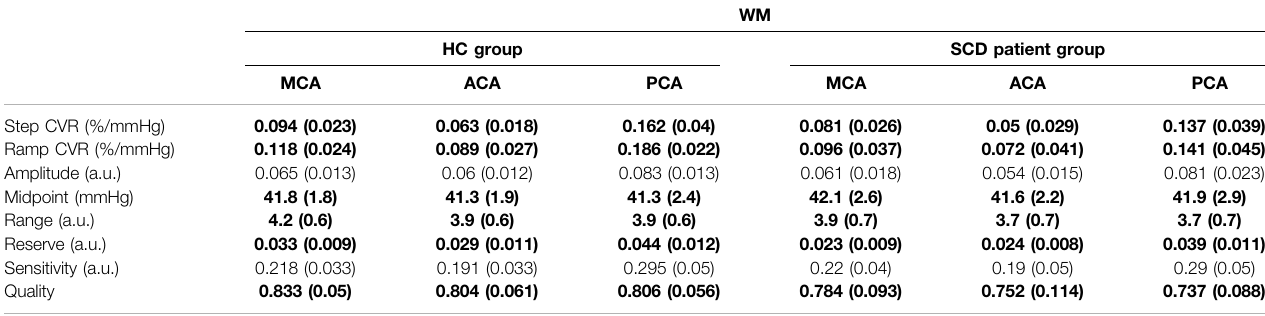
TABLE3| Theaveragewhitematter(WM)CVRandresistanceparametersinHCandSCDpatientgroupsforthemiddlecerebralartery(MCA),anteriorcerebralartery(ACA) and posterior cerebral artery